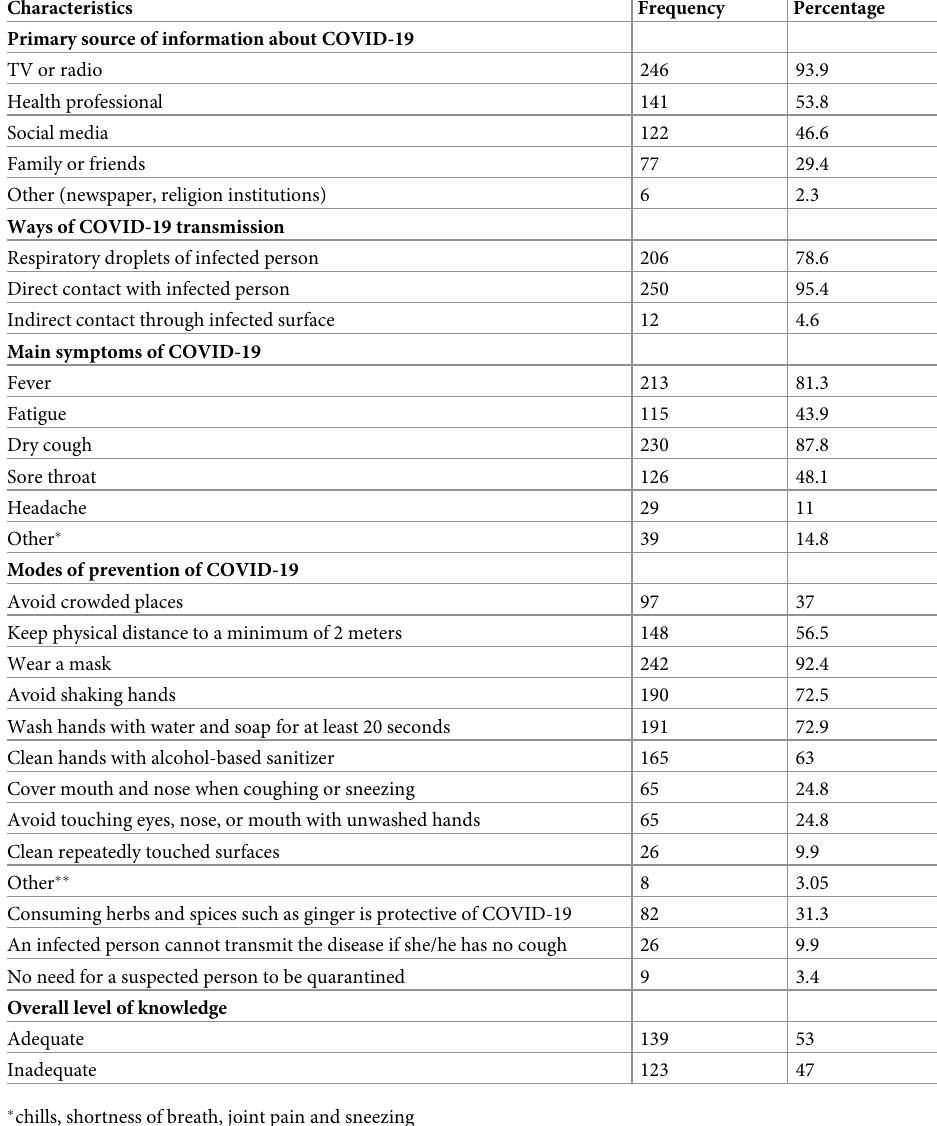
Table 3. Knowledge of COVID-19 prevention, symptoms, and transmission among respondents.